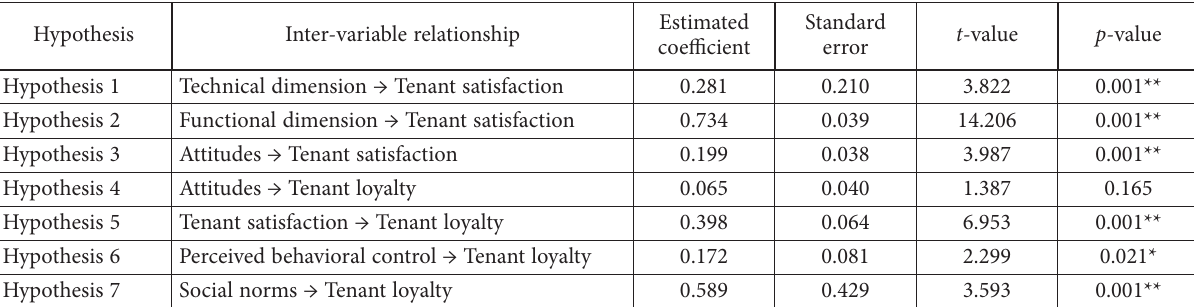
Table 6. Estimation results of the linear structural equation model